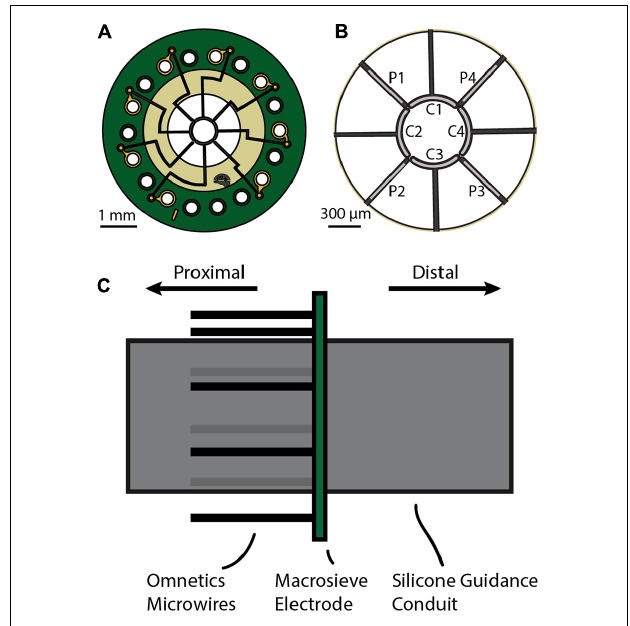
FIGURE 1 | (A) The macro-sieve electrode (MSE) is a circular disc with three concentric rings: a central active region, a middle polyimide ring, and an outer PCB board. The active region has nine transit zones through which axons regenerate. It also has a circular hub and radiating spokes that together hold eight platinum-iridium leads that inject current into adjacent nerve tissue. The middle polyimide ring houses embedded traces that relay current to the leads from solderable through-holes located on the outer PCB ring. (B) Enlarged view of the active region. The circular hub and radiating spokes together define the boundaries of the nine transit zones. The circular hub houses four core leads (C1, C2, C3, and C4). Alternating radial spokes house four peripheral leads (P1, P2, P3, and P4). (C) Side view of the MSE assembly prior to implantation. Silicone guidance conduits affixed to either side of the polyimide ring will guide regenerating axons through the transit zones. Eight microwires from the attached Omnetics connector are soldered to the PCB’s contact pads to interface the leads with an external